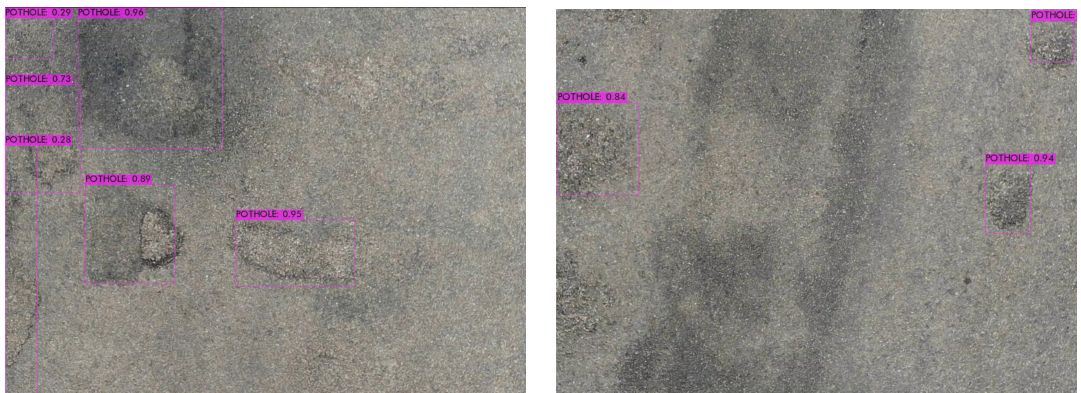
Figure A2. Detection results.